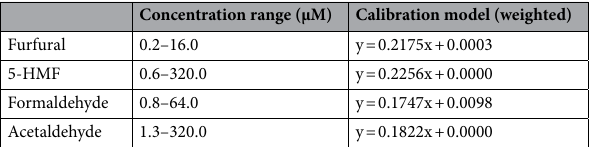
Table 1. Calibration models for the quantification of monocarbonyl glucose degradation products in